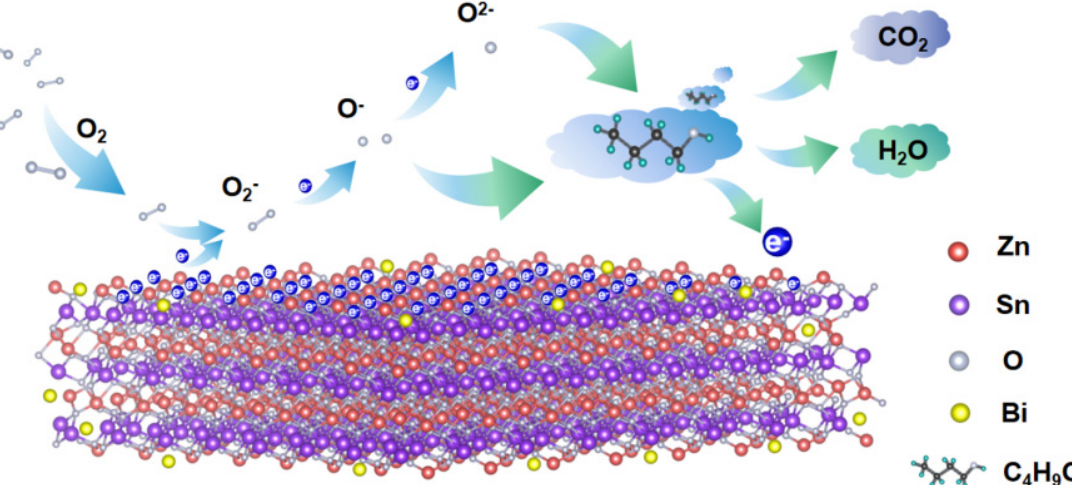
Figure 11. Gas − sensing mechanism of Bi-ZnSnO 3 composites.